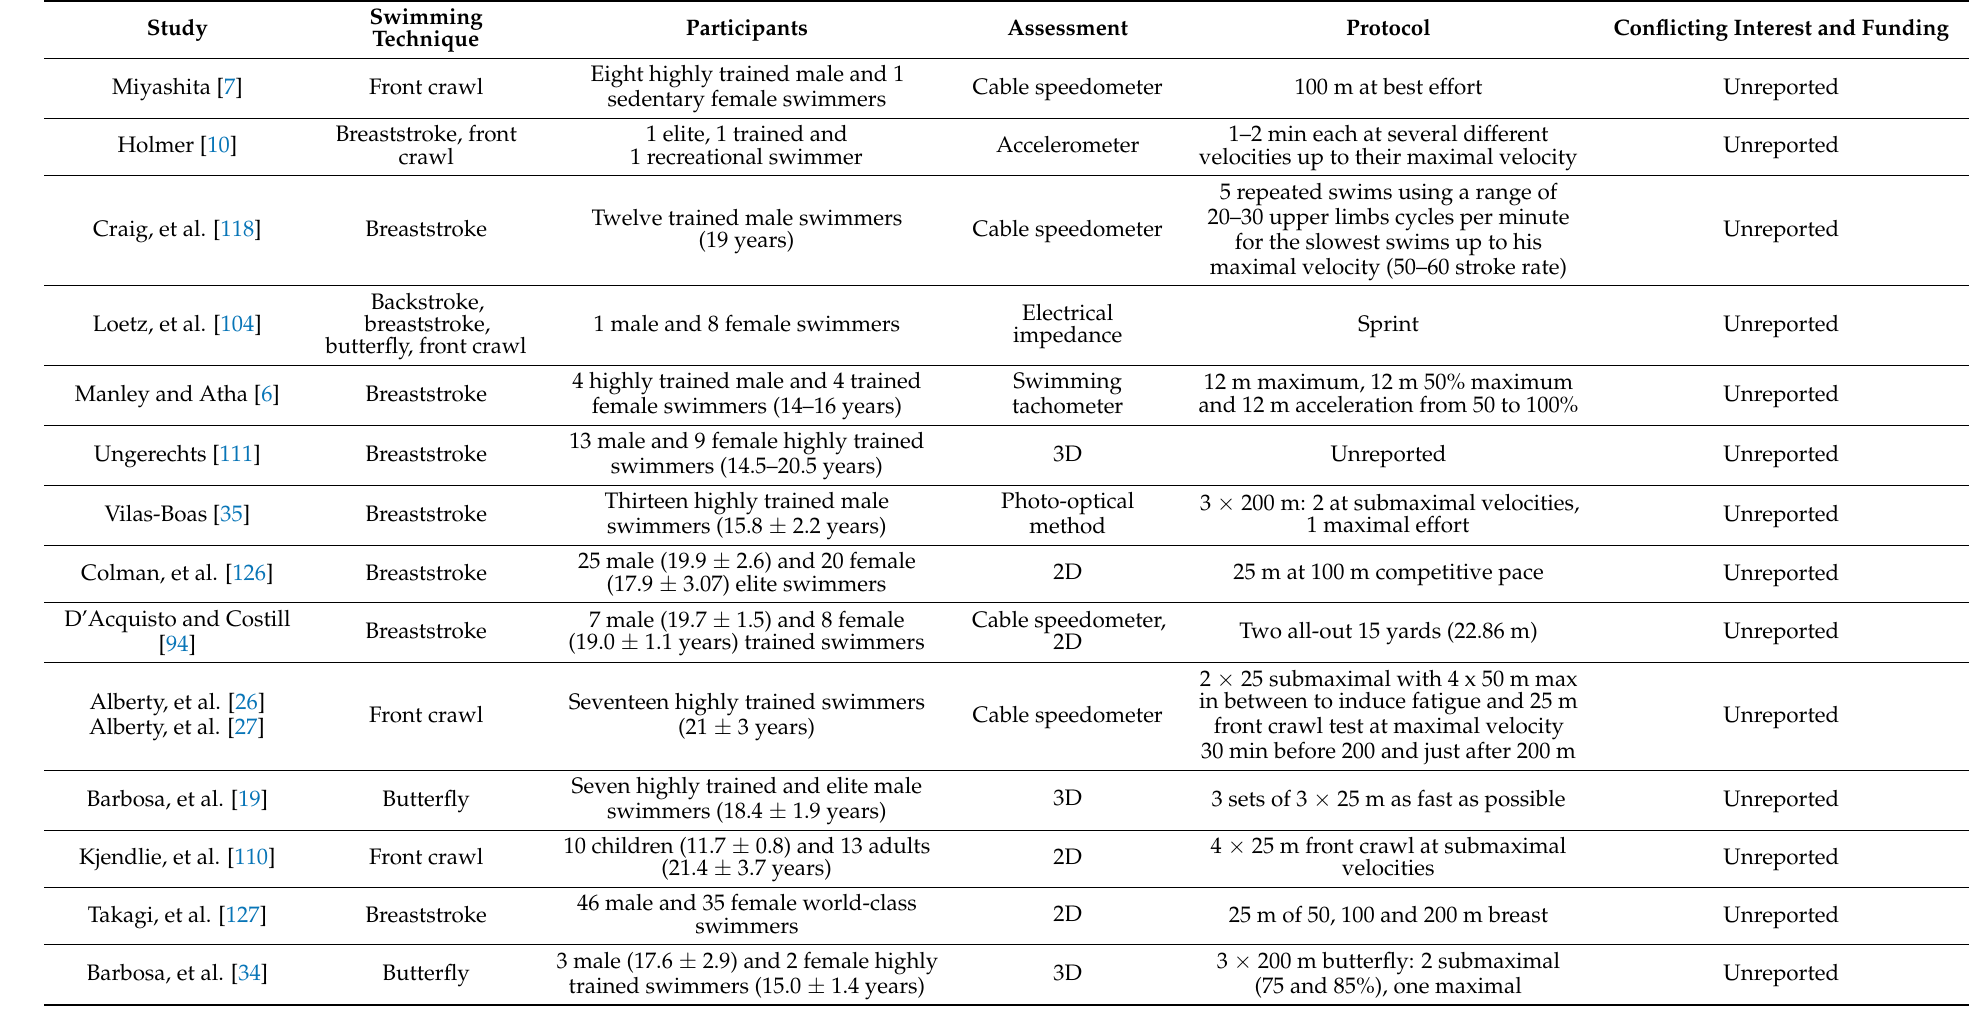
Table 2. List of included trials and respective main characteristics (including the evaluated swimming technique, the participants characteristics, the used methodology, the conflicts of interests and the corresponding